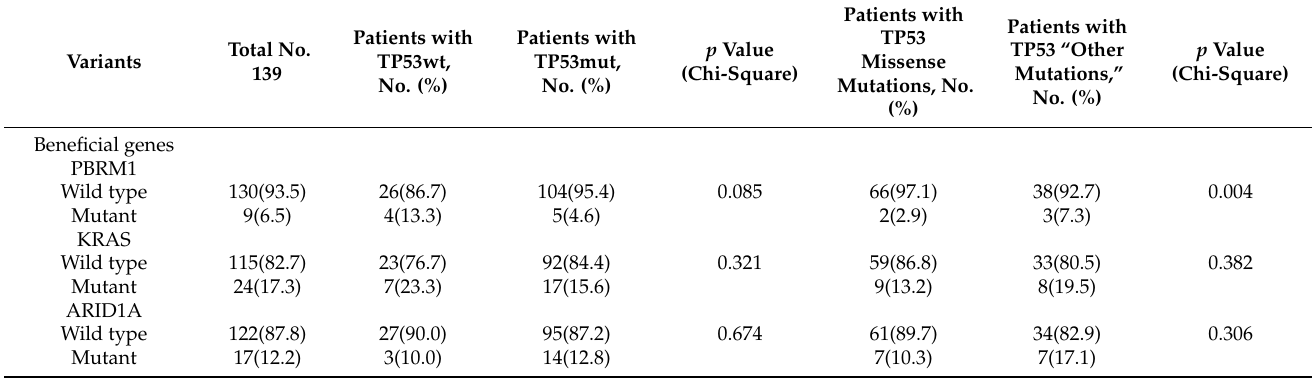
Table 2. Co-mutational status for patients with TP53wt and TP53mut in advanced lung